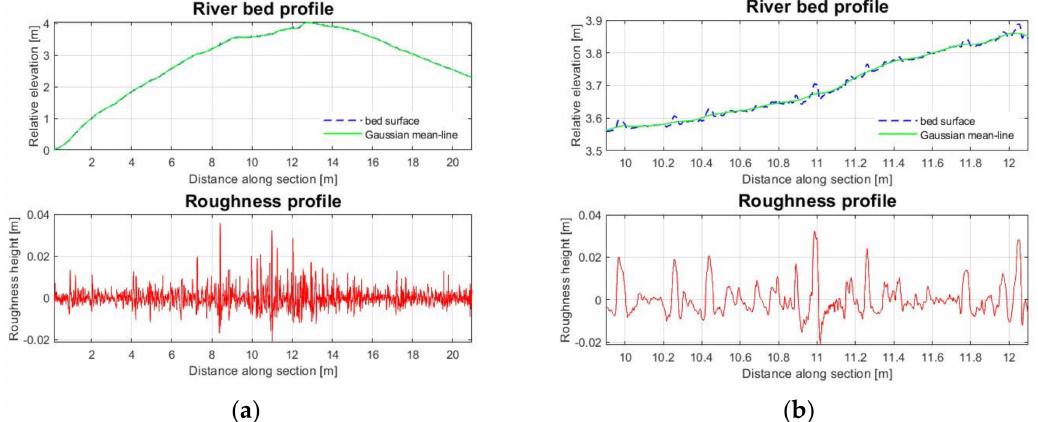
Figure 13. ( a ) The bed elevation ( top ) and the calculated roughness profile ( bottom ). ( b ) A coarser part from the analyzed section (middle part in Figure 13a). On ( top ), the bed surface and the Gaussian mean-line can be seen. From these two, the roughness profile is calculated ( bottom ).